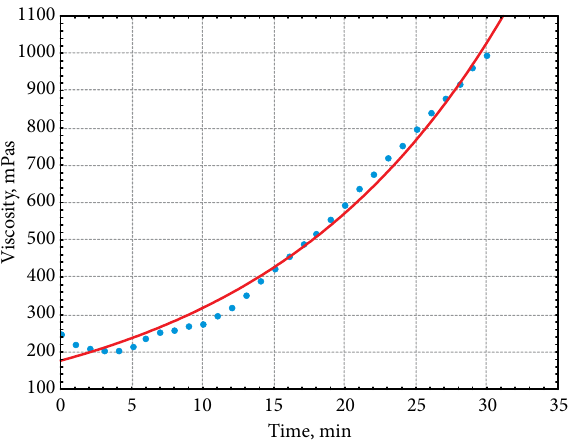
Fig. 6. The relationship between viscosity and time in cement paste containing 5 wt% of synthetic